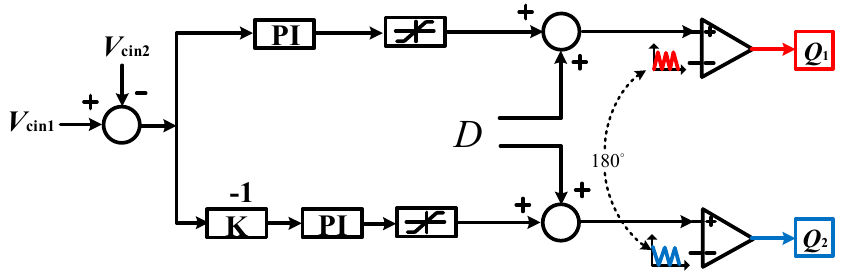
Figure 13. Modulation block diagram of the front-end three-level buck converter.